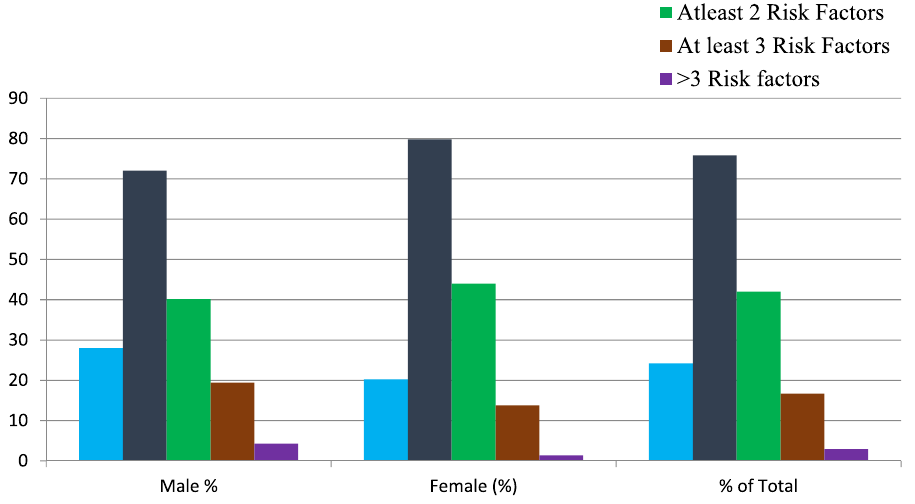
Figure 2. Summary of combined risk factors by sex of study participant based on ATP III definition, EPHI, Addis Ababa, Ethiopia, 2018 (n =